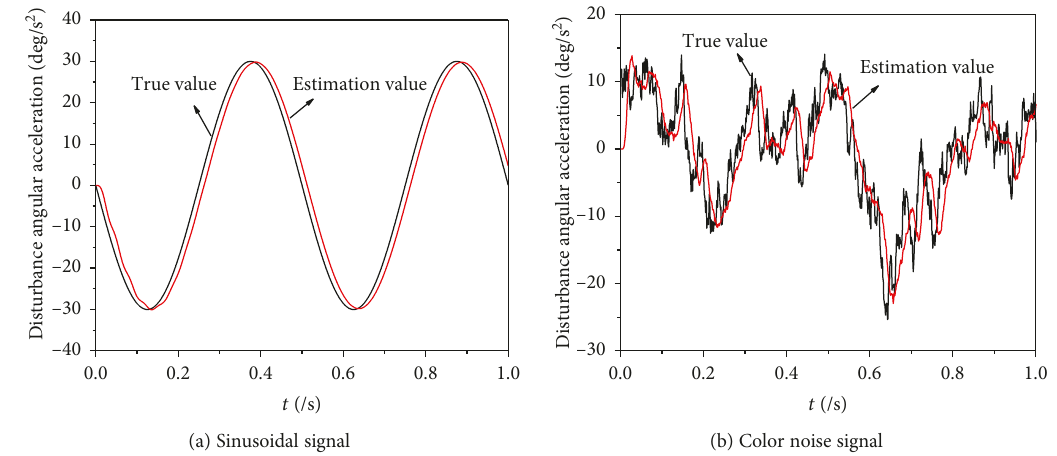
Figure 10: Disturbance angular acceleration.